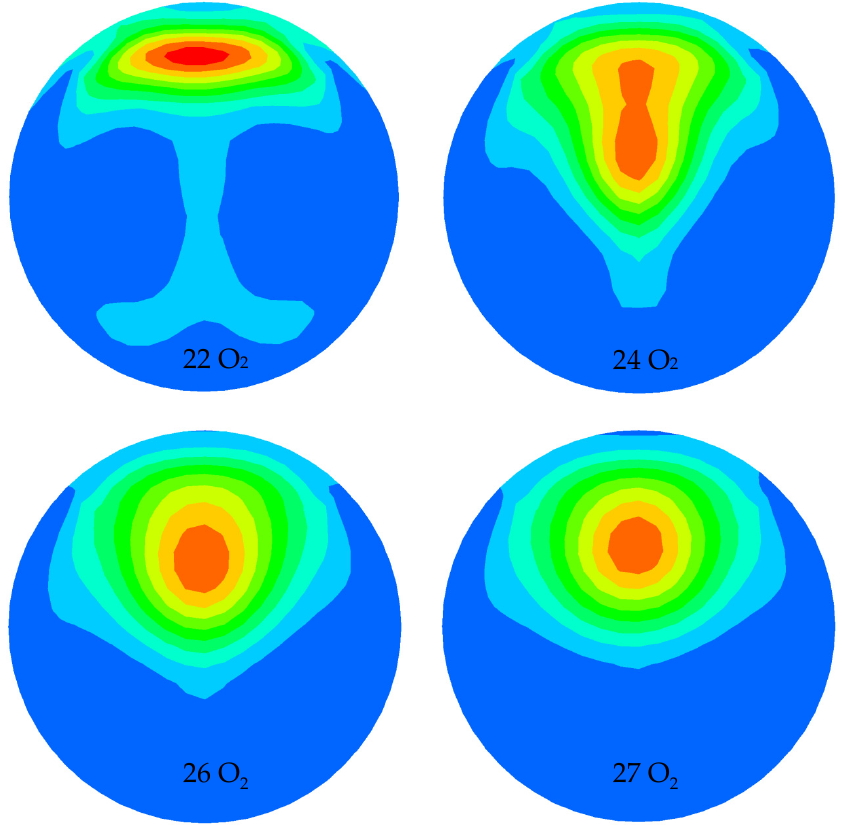
Figure 12. Distribution of 18 O 2 at raceway outlet.